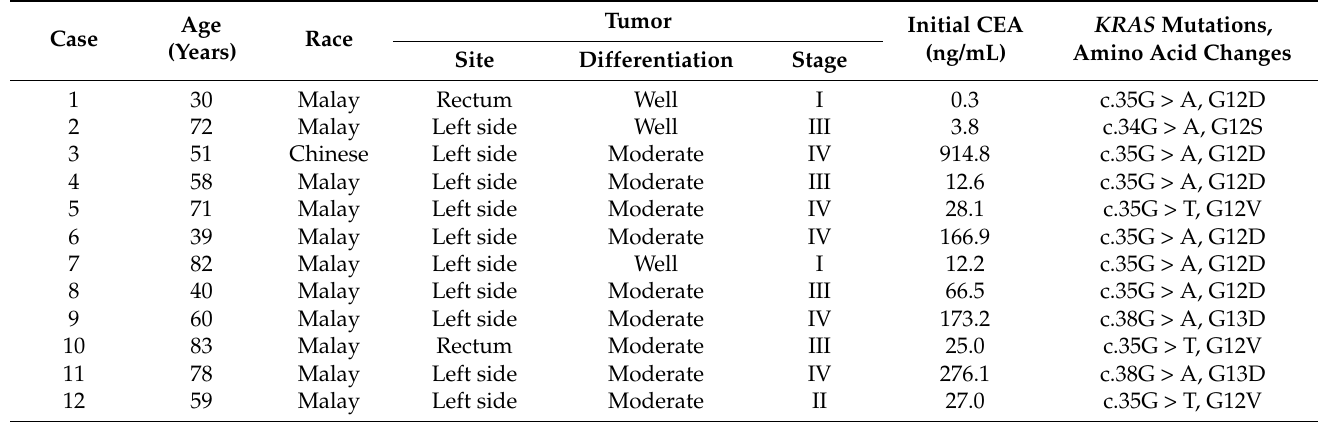
Table 4. Characteristics of colorectal cancer patients with mutant KRAS and their clinicopathological